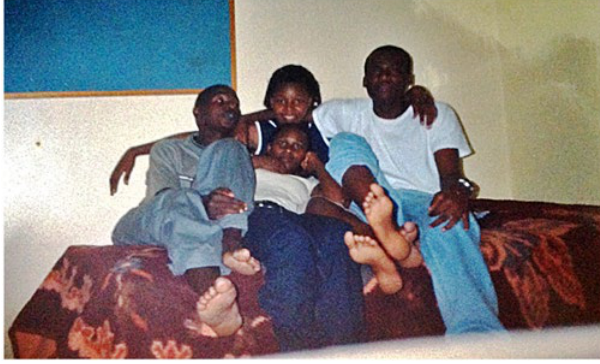
Figure 1: TM outside his house in